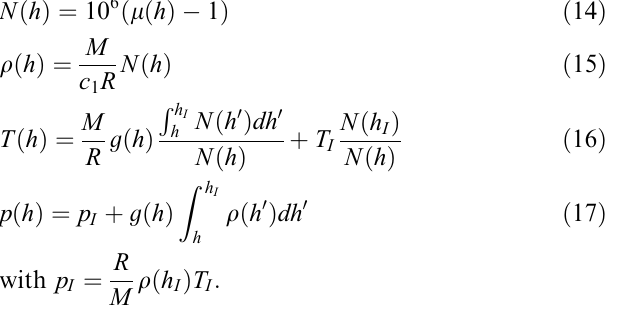
Fig. 4. E(cid:128)ect of di(cid:128)erent initialization heights of the Abelian integral inversion on the temperature profile. The dotted lines are due to the retrieval procedure without statistical optimization. The solid lines denote the curves derived with the statistical optimization approach for the bending angle data between 40 km and the